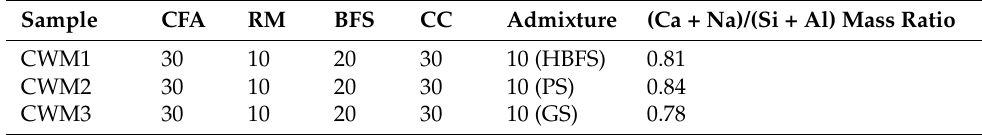
Table 2. Proportion of raw materials (wt.%).